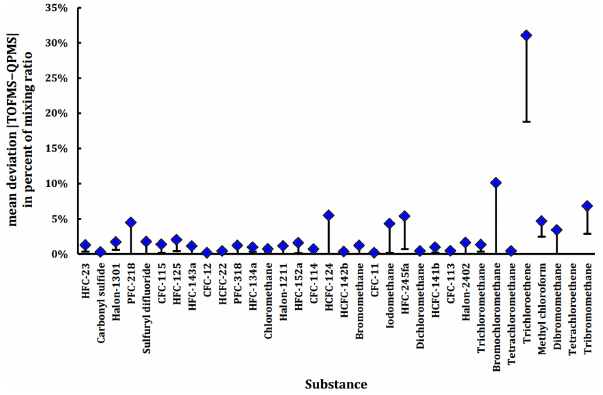
Figure 11. Mean deviation of mixing ratios determined with the GC-QPMS and the GC-TOFMS in the four InGOS round robin flasks. X axis: list of the 33 substances analysed, order based on retention times on the GC-quadrupole MS. Y axis: average absolute deviation of both instruments in [%]. GC-TOFMS results were derived from accurate mass intensities. Error bars: uncertainty calculated by Gaussian error propagation of the 1 σ measurement precision of both